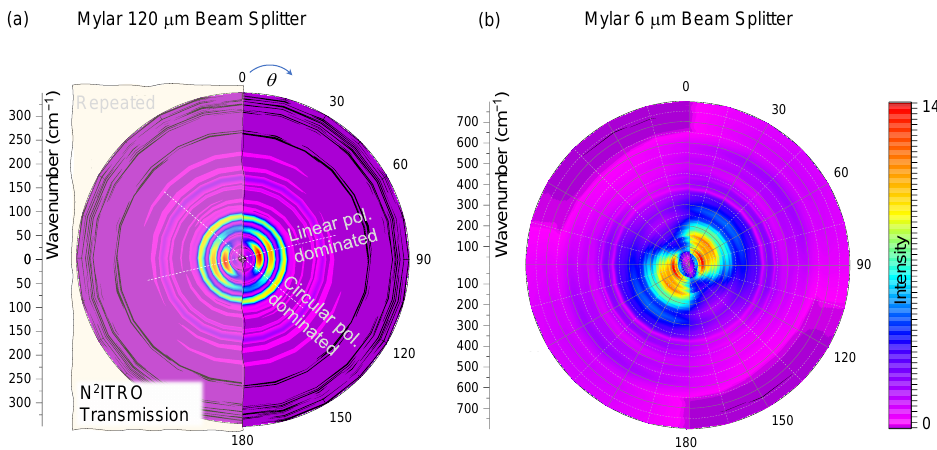
Figure A1. Angular dependence of the narrow and broadband THz radiation with beam splitters: ( a ) 120 and ( b ) 6 µ m Mylar, respectively, measured in transmission mode with wire mesh polariser with ∆ θ = 15 ◦ steps using N 2 ITRO unit (with no sample; see Figure 2). Angular measurements were carrier out in the θ = 0 − π range and repeated to complete 2 π polar plot (old 1st mirror).